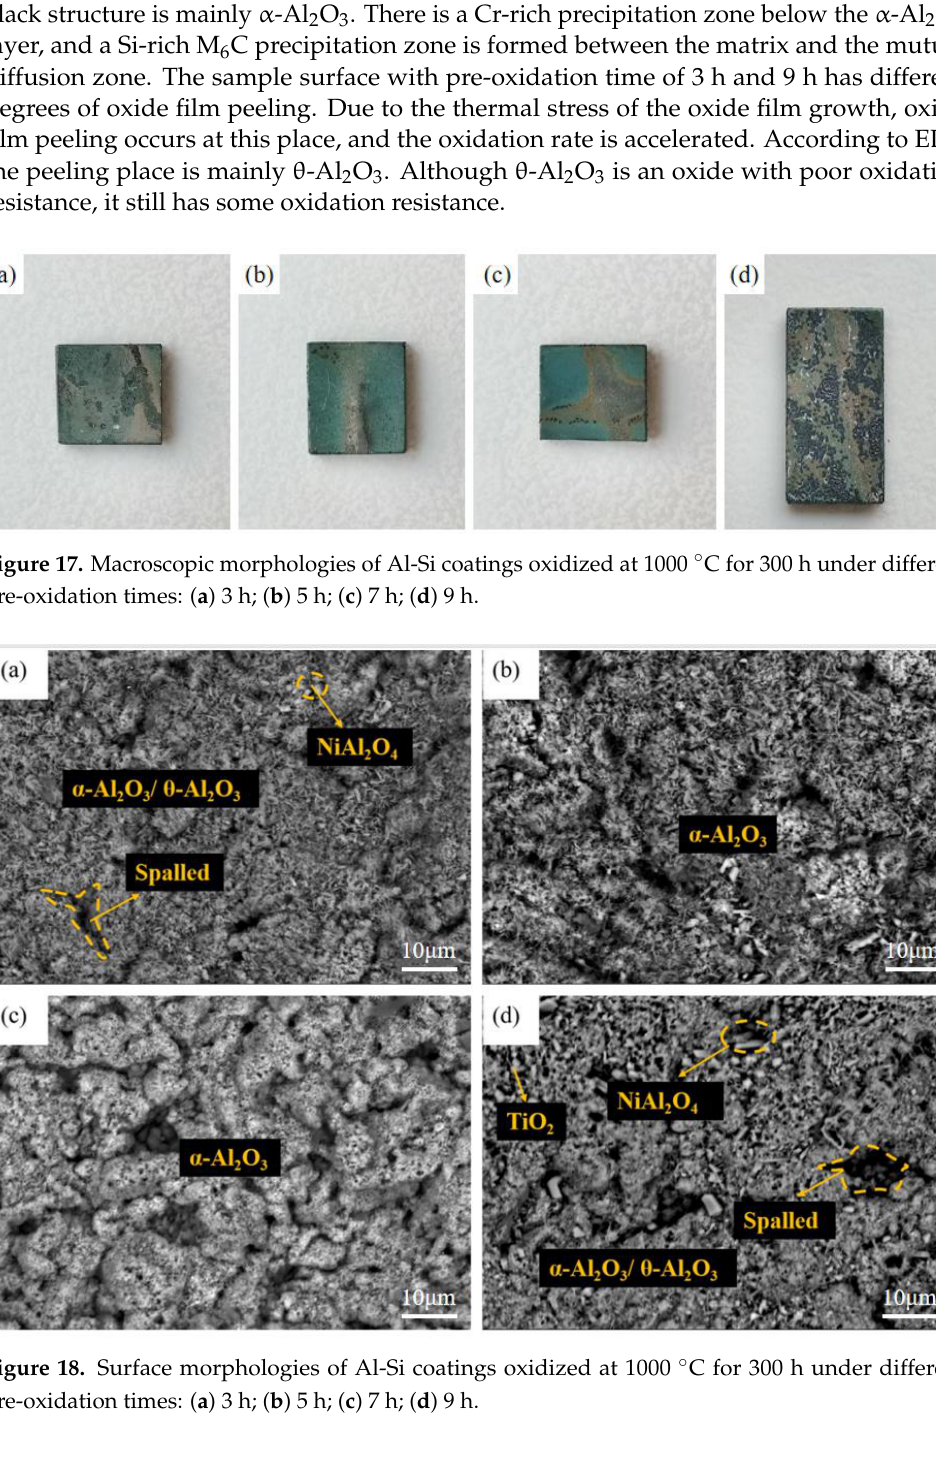
Figure 19. Cross-sectional morphologies of Al-Si coatings oxidized at 1000 °C for 300 h under dif- ferent pre-oxidation times: ( a ) 3 h; ( b ) 5 h; ( c ) 7 h; ( d ) 9 h. At different pre-oxidation times, Figure 15 shows that Ti is mainly distributed in the outer layer of the coating and the precipitation zone rich in Cr, Si and other elements dur- ing pre-oxidation. Formation of more TiO 2 was found when the oxidation time was 300 h. Figures 18d and 19d show that long strips of TiO 2 and typical spinel oxide Ni(Al,Cr) 2 O 4